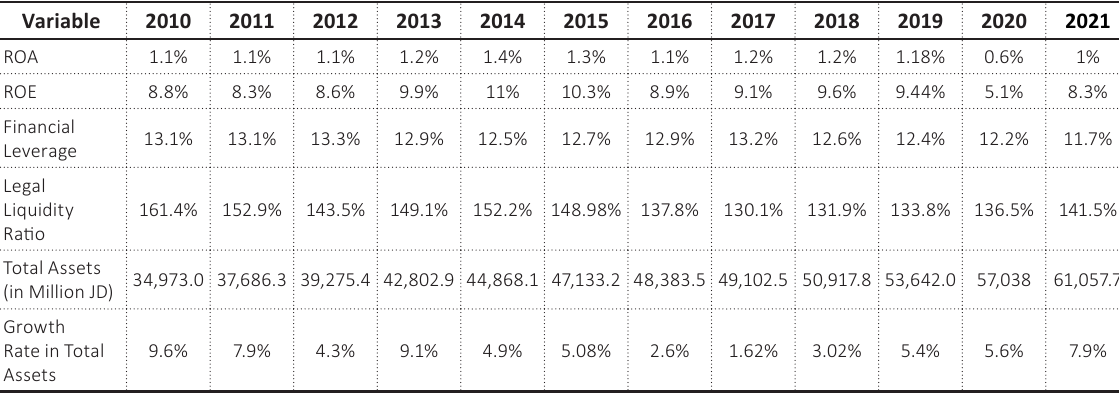
Table 2. Performance indicators for the Jordanian banking sector, 2010–2021